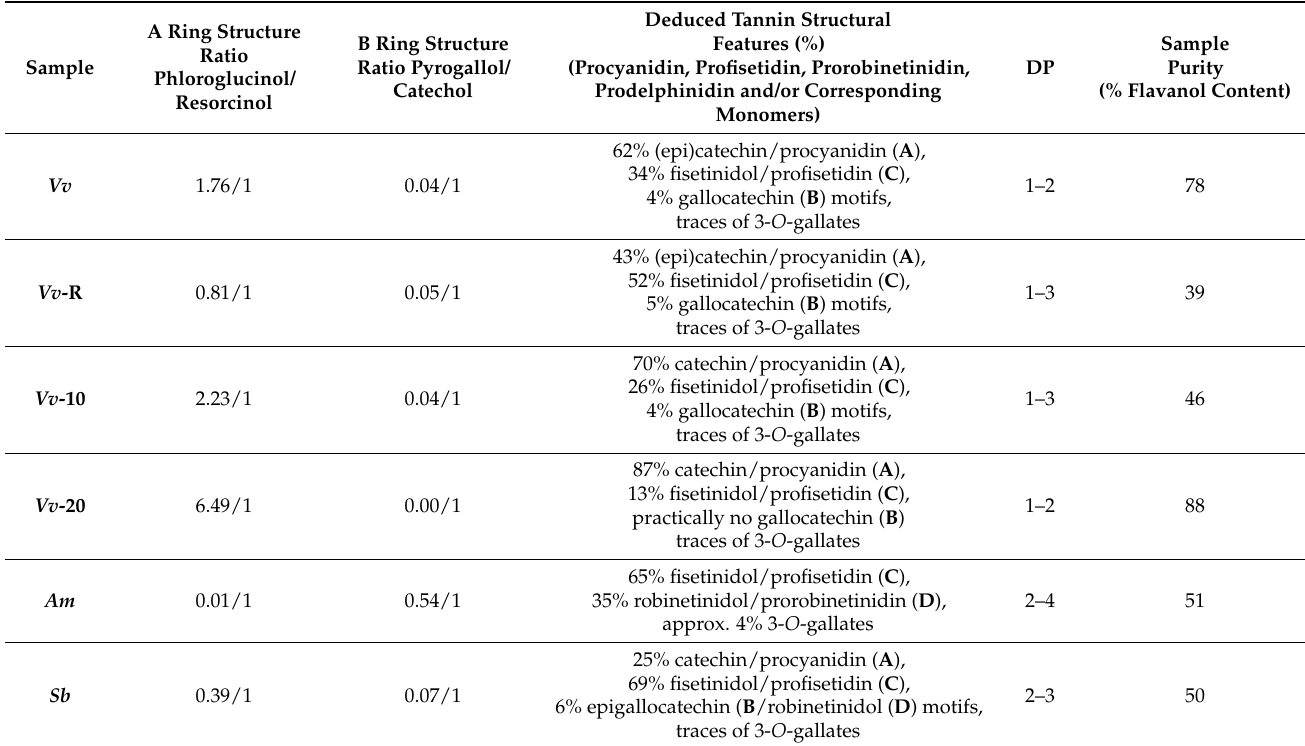
Table 3. Structural features of the A and B Rings, as well as flavan-3-ol content in commercially available condensed tannins as delineable by 31 P NMR spectroscopy and GPC analyses. Structural purity has been determined as described before [30]; gallate ester content is estimated based on the same molecular